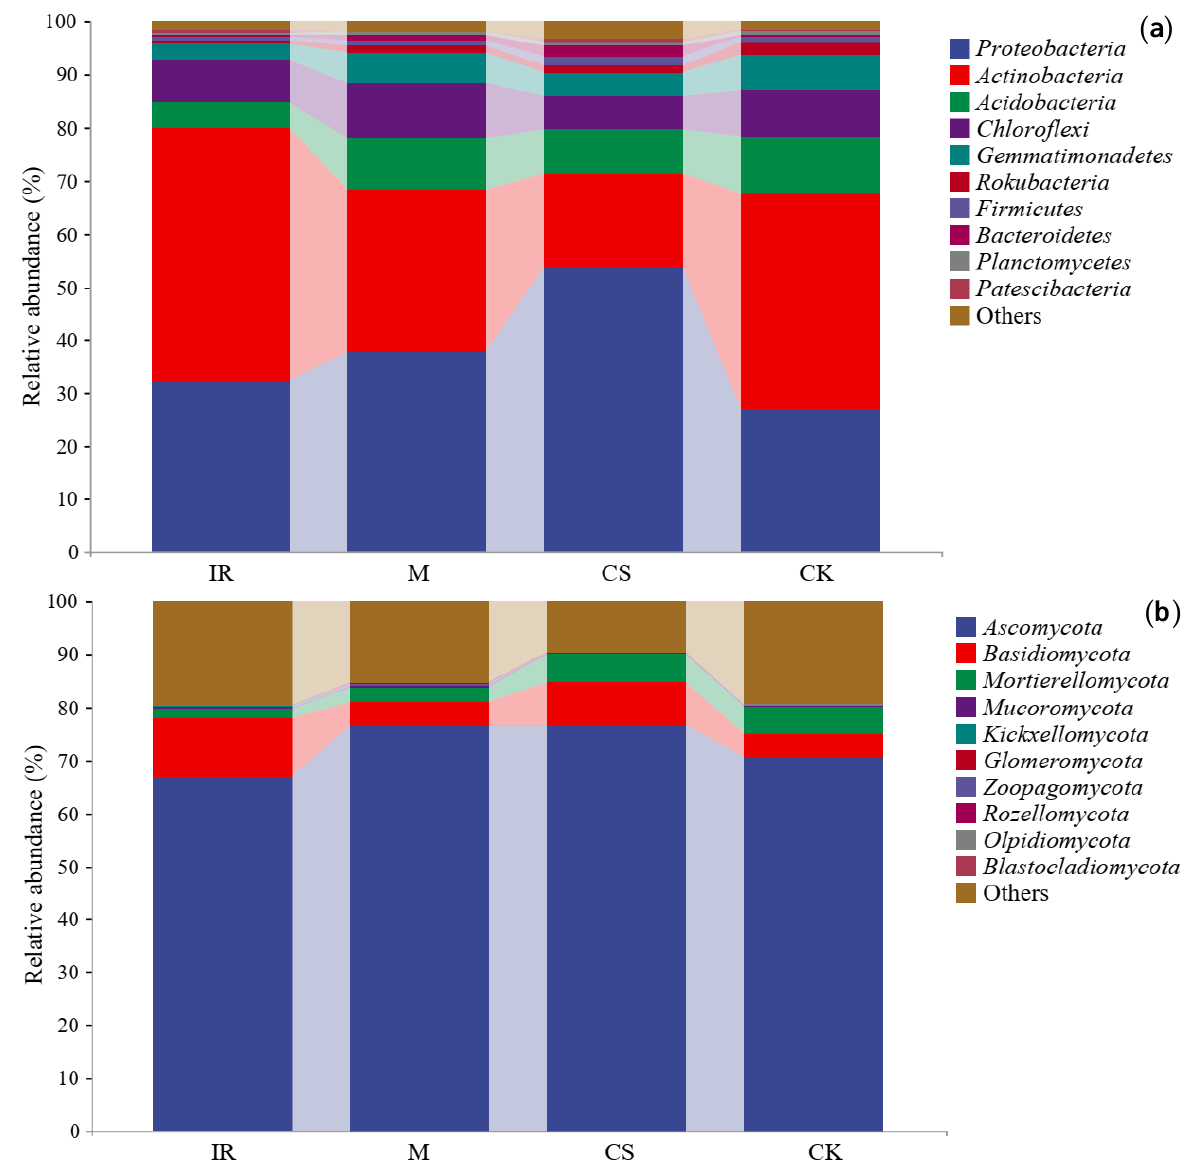
Figure 4. The relative abundance of major bacterial and fungal taxonomic groups at the phylum associated with the sample plots. ( a ) Bacteria; ( b ), fungi. IR, Italian Riesling; M, Merlot; CS, Cabernet Sauvignon; CK, control check (desert land).